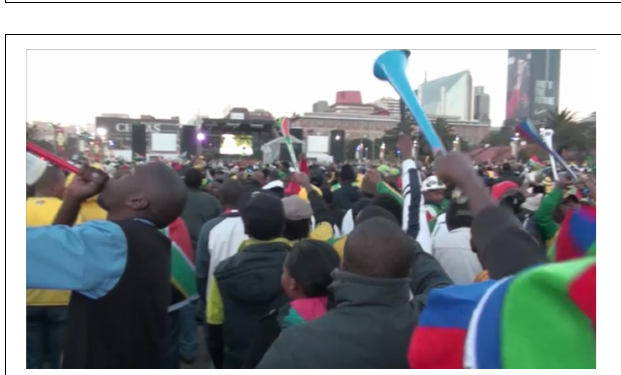
FIGURE 8 | Crowds continuing to dance, sing and play vuvuzelas after South Africa’s first goal in a World